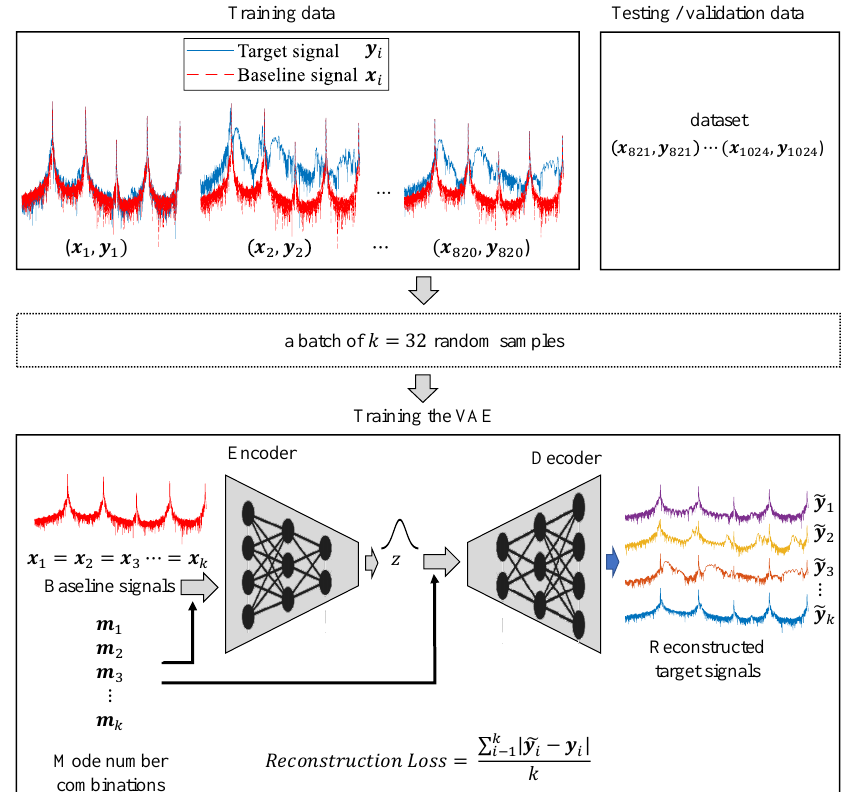
Figure 6. VAE architecture illustrating the training process with a batch size of k random samples from the training